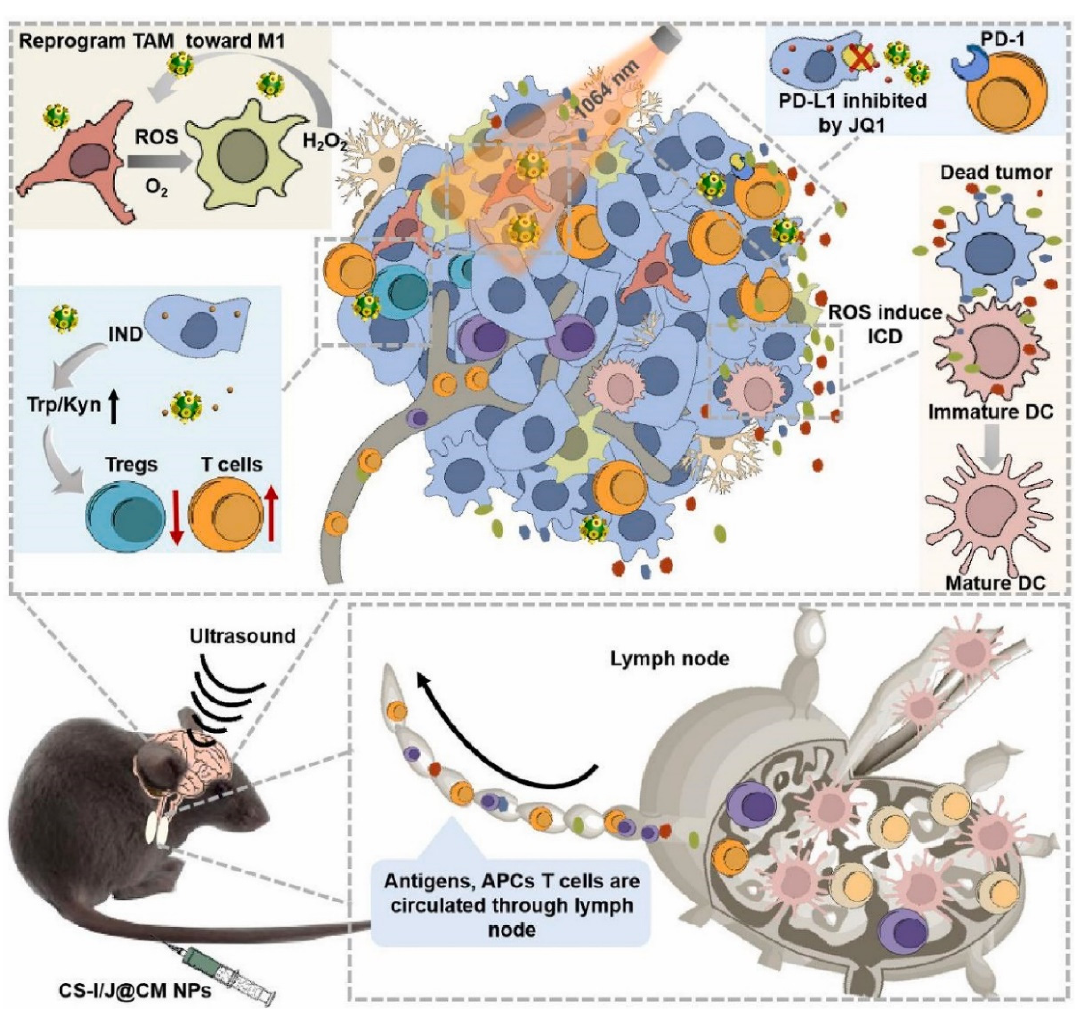
Figure 7. Integrated CS-I/J@CM NPs remodel the tumor immunosuppressive microenvironment to improve glioblastoma immunotherapy [63].